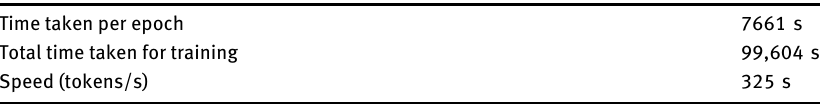
Table 5: Average Time Taken for Training.